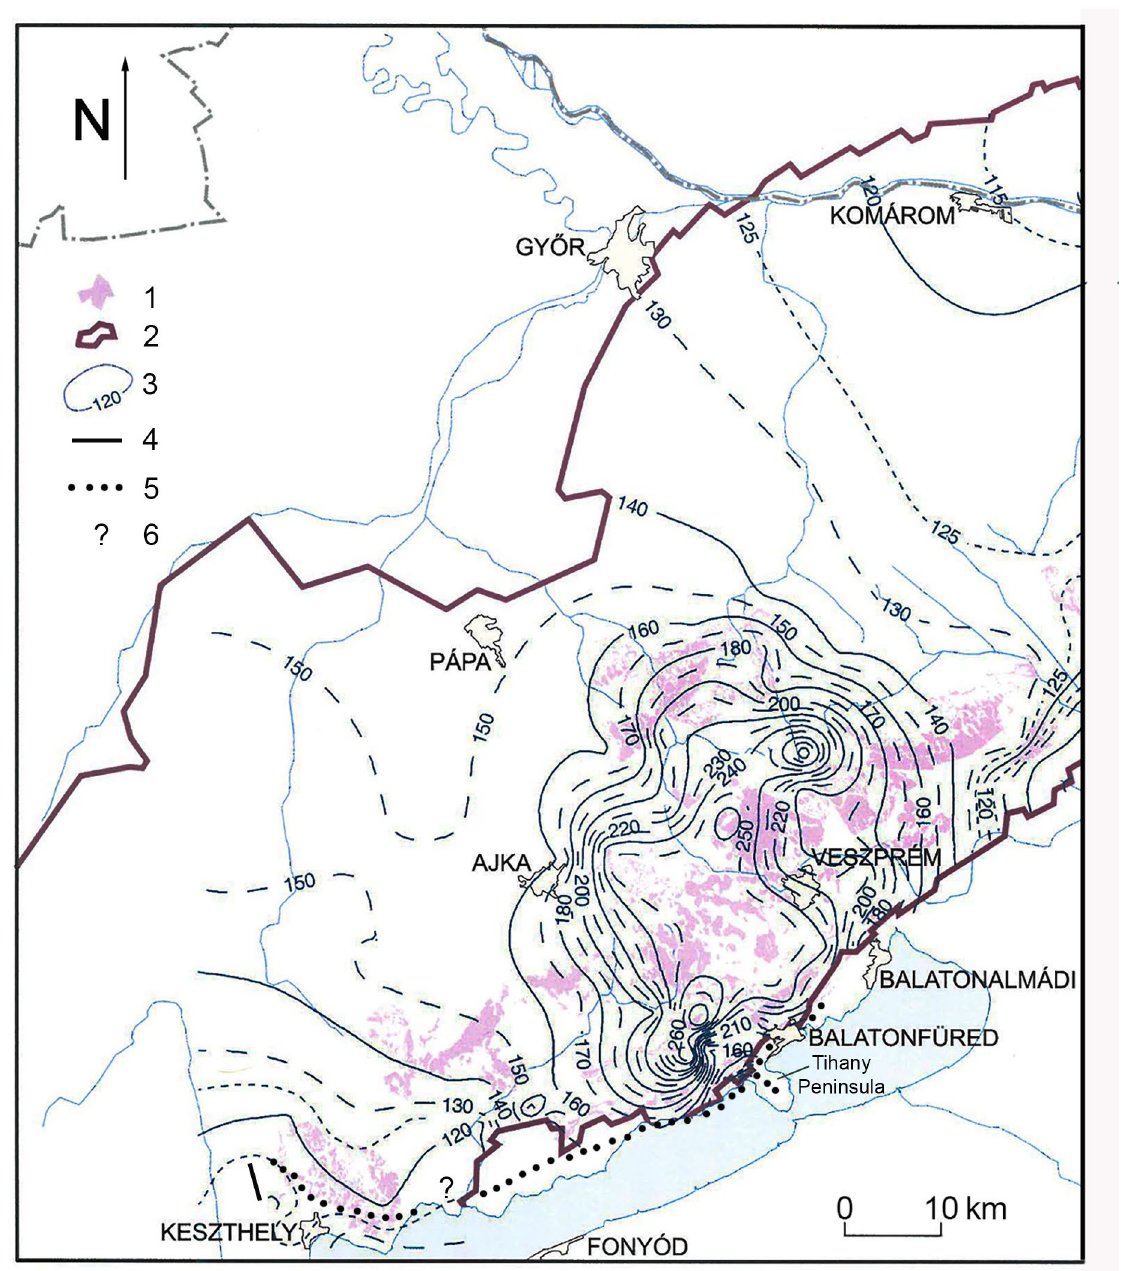
Figure 3. Karstwater map of the Bakony Mountains [21]. Regional groundwater of the mountains according to the state of January 2006. Legend: 1. infiltration area, 2. boundary of groundwater storage, 3. altitude of the isoline of groundwater level, 4. hypogene branch, 5. former hypogene branch, 6. termination boundary is not known